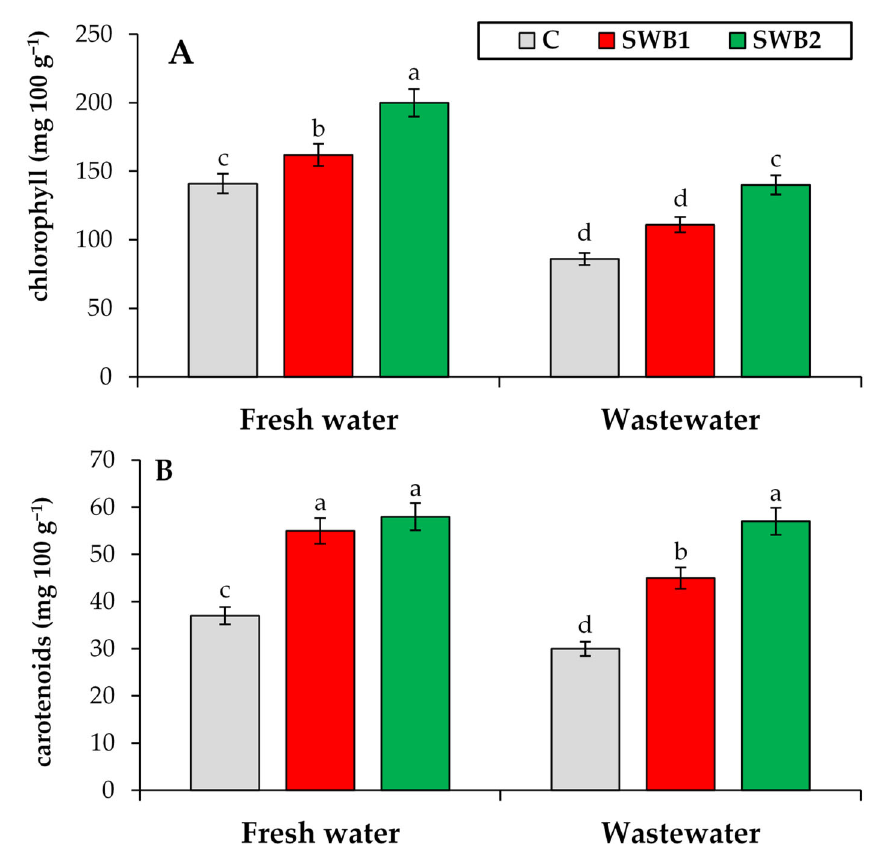
Figure 2. Effect of shrimp-waste-derived biochar (SWB) rates in photosynthetic pigments in quinoa leaves. C, SWB 1 , and SWB 2 are 0, 1, and 2% ( w / w ) of biochar. ( A ) chlorophyll and ( B ) carotenoids. Means (±SD, n = 5) with different letters indicate significant differences.